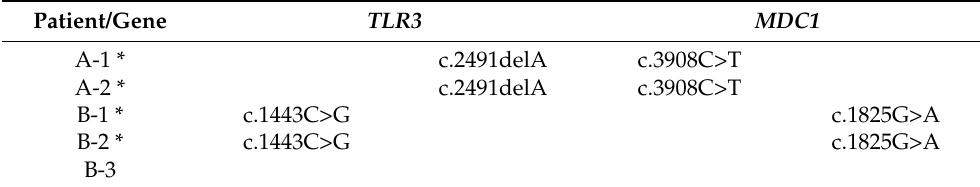
Table 2. Candidate gene variants found in Families A and B.